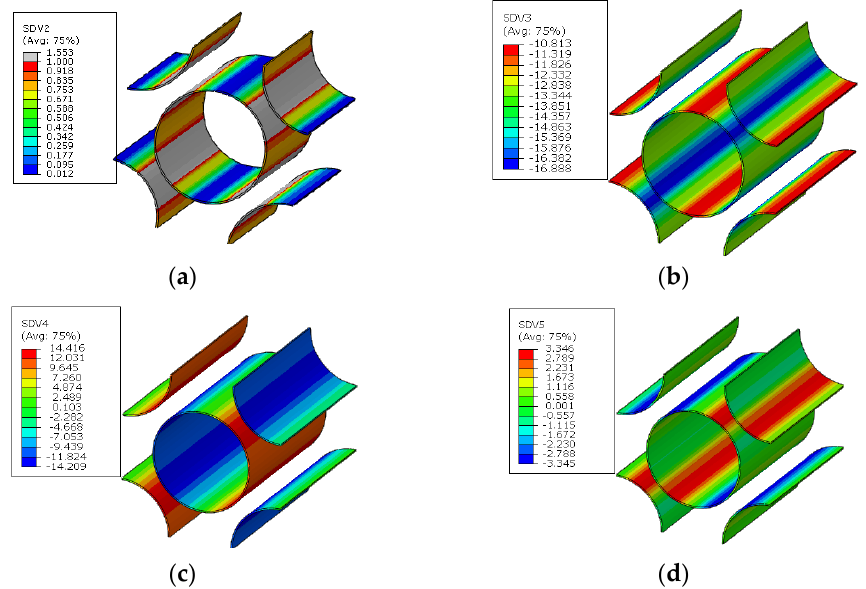
Figure 19. Failure indices and traction force states for the interface. ( a ) failure indices; ( b ) normal traction; ( c ) longitudinal shear traction; ( d ) tangential shear traction.